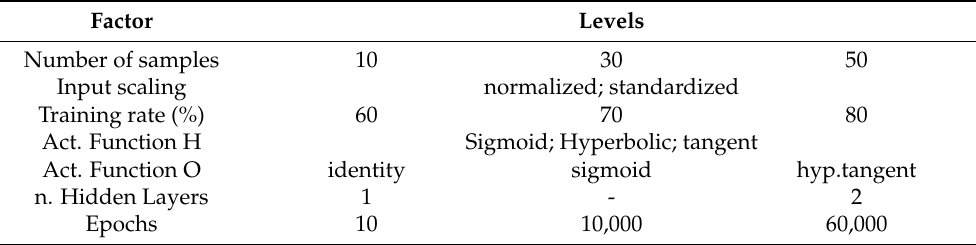
Table 1. Signal (or control) factors and their